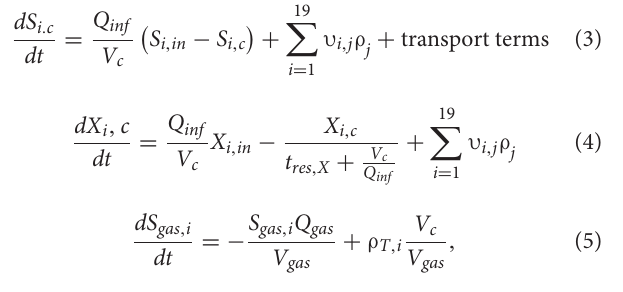
Where dS i , c and dX i , c represent the time derivatives of the dt dt